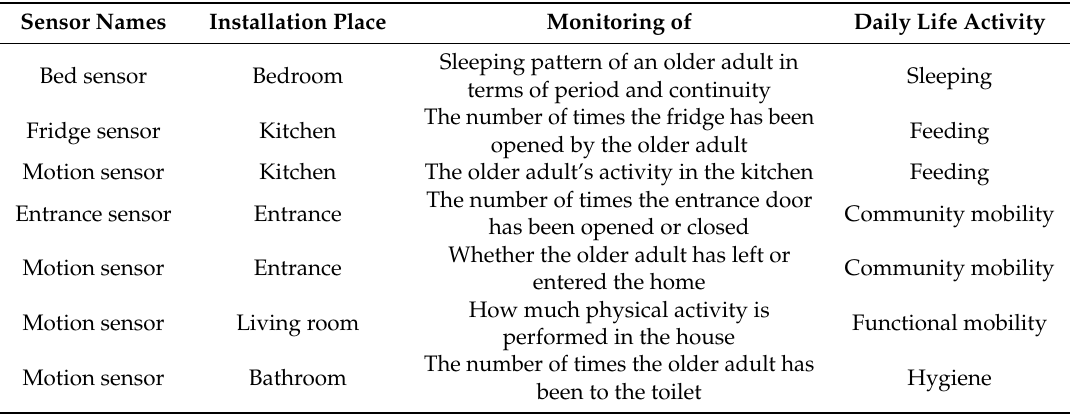
Table 4. Types of sensors installed in the home and the monitored daily life activity.